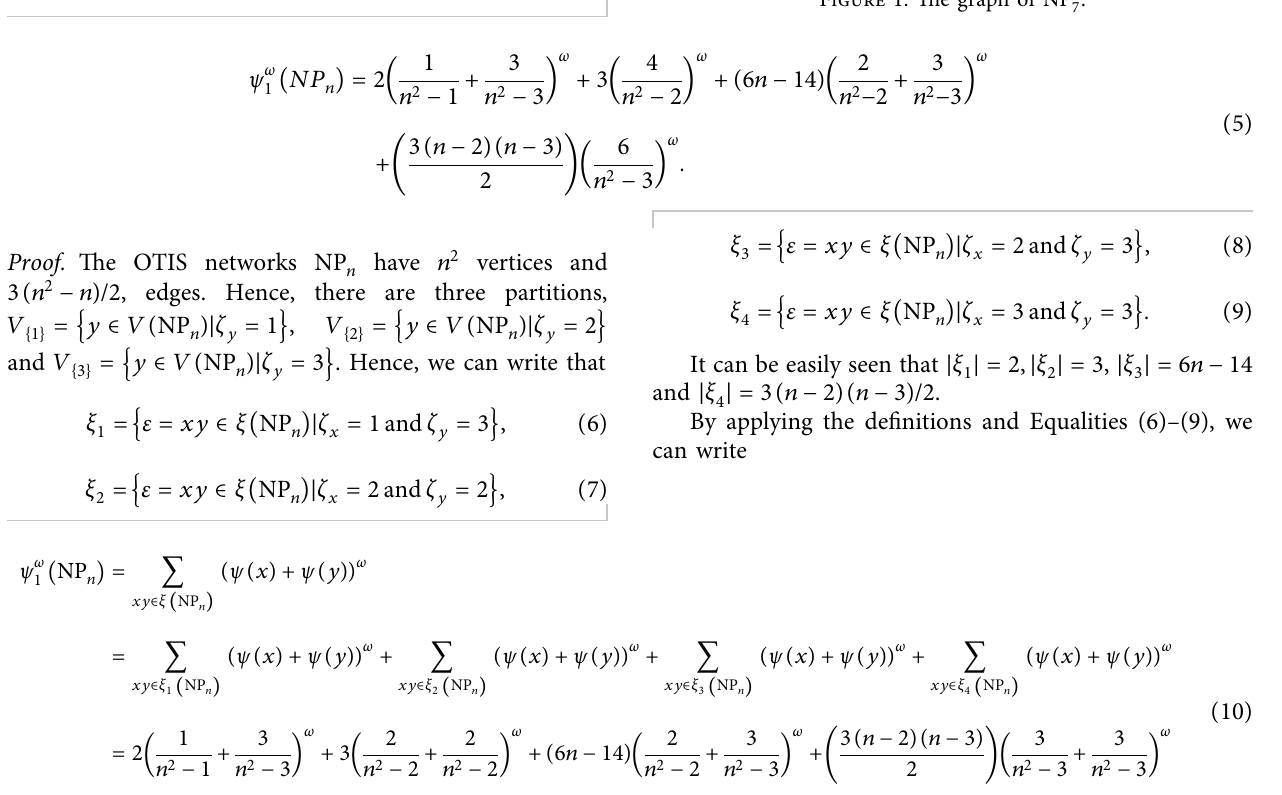
Figure 1: The graph of NP